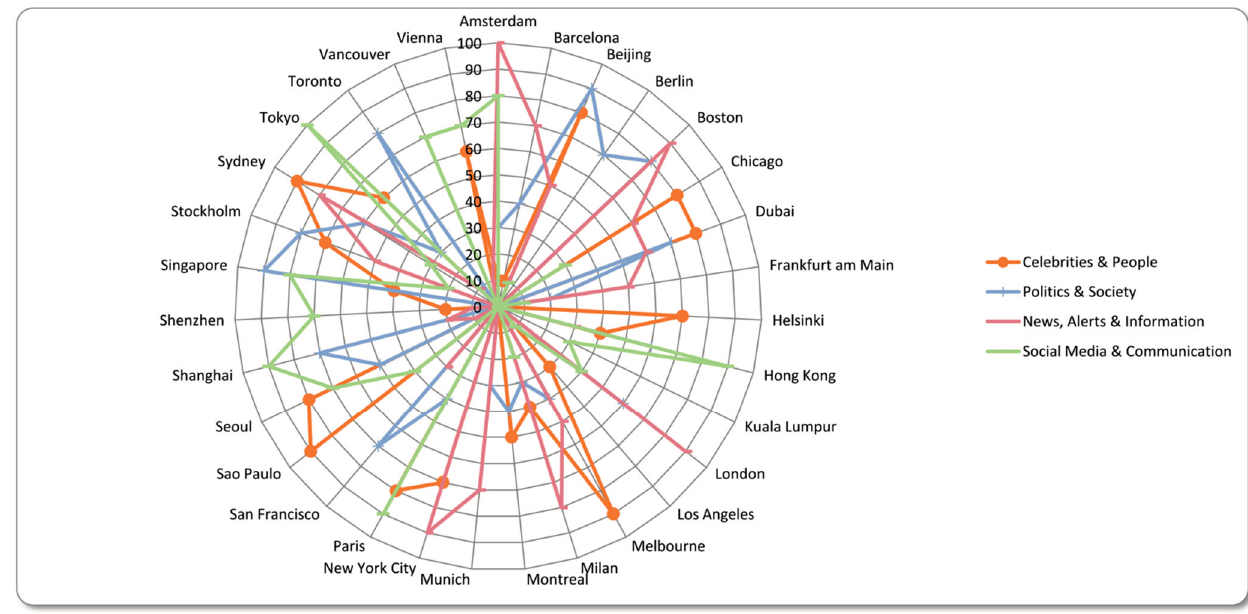
Figure 6. The most important topics in tweets